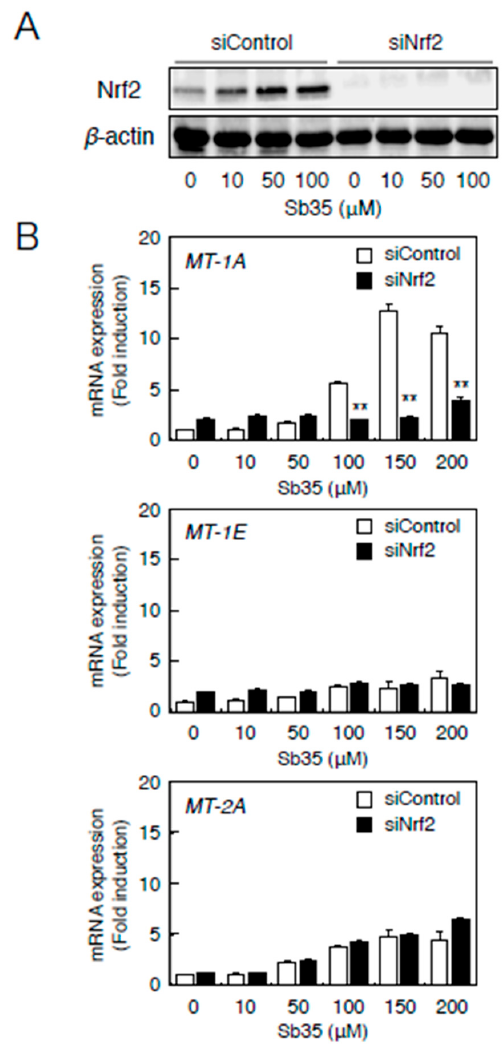
Figure 5. The Nrf2–ARE pathway mediates Sb35-induced transcription of endothelial MT-1A , MT-1E , and MT-2A . ( A ) Expression of Nrf2. Vascular endothelial cells transfected with control or Nrf2 siRNA were treated with or without 10, 50, or 100 µM Sb35 for 24 h, and expression of Nrf2 was determined by performing Western blotting; ( B ) Sb35-induced transcription of endothelial MT-1A , MT-1E , and MT-2A after Nrf2 knockdown. Vascular endothelial cells transfected with control or Nrf2 siRNA were treated with or without 10, 50, 100, 150, or 200 µM Sb35 for 12 h. Data are expressed as the mean ± SE of three representative samples, with each sample obtained from three independent experiments. ** p < 0.01 indicates significantly different from the corresponding siControl.